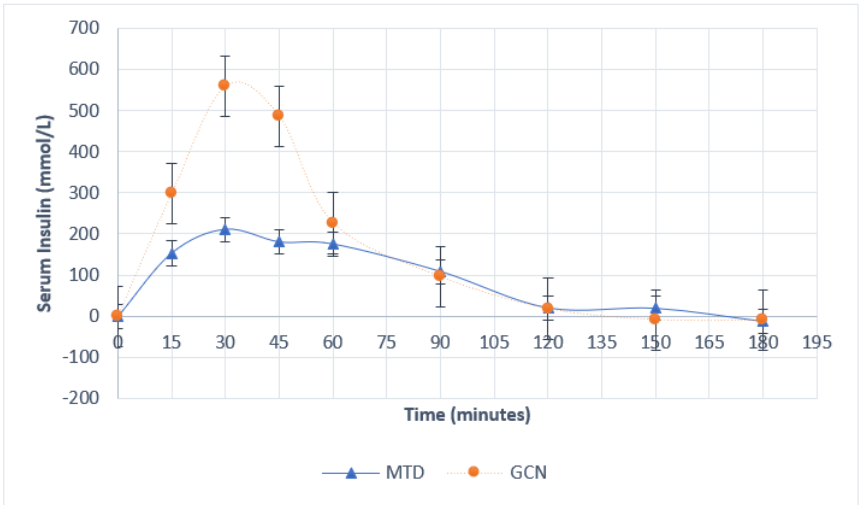
Figure 2. Serum insulin concentrations over time. E rror bars represent SEM.